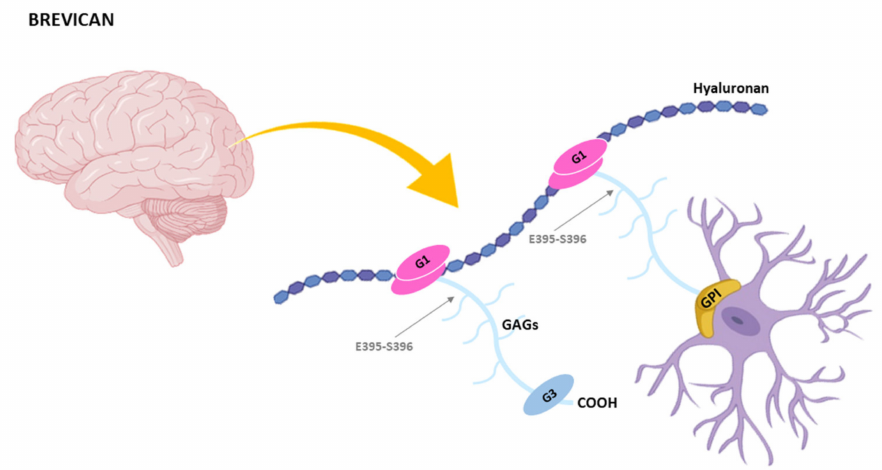
Figure 5. Representation of brevican structures. Brevican is expressed in brain and a GPI-anchored isoform lacking G3 domain has been identified. GAGs, glycosaminoglycans. Arrows indicate the main cleavage site by ADAMTS-4. Other cleavage sites are indicated in the